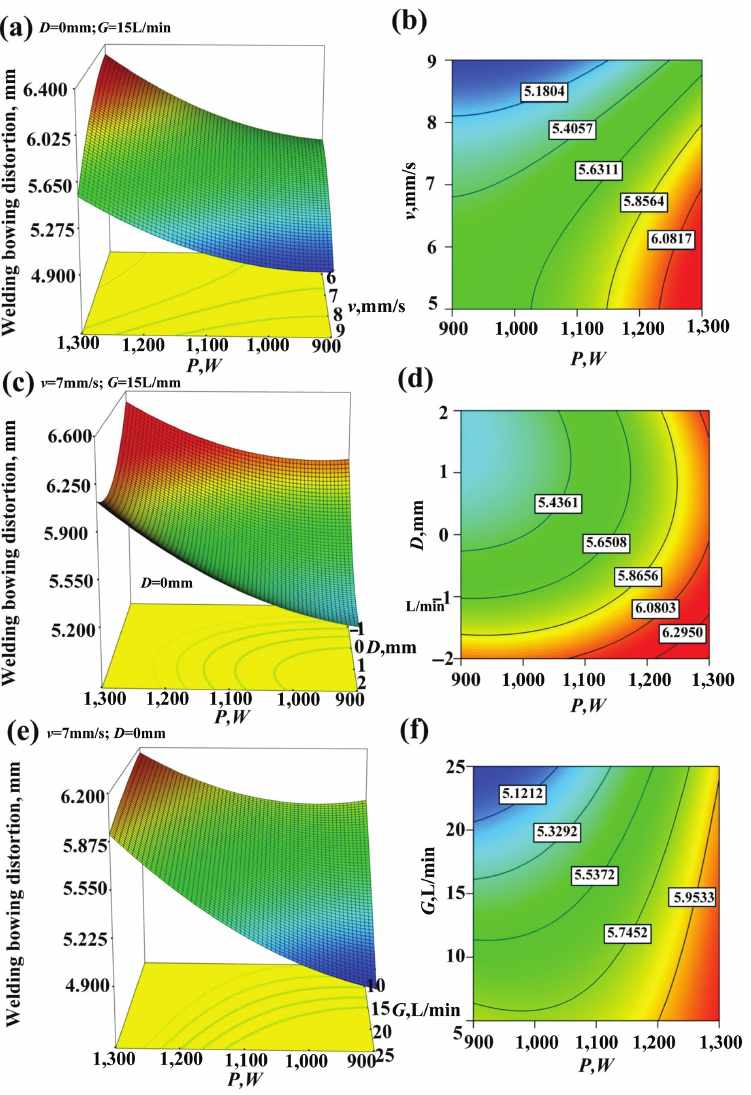
Figure 8: 3D response surface graphs and con- tour plots based on the quadratic model: (a), (c), (e) response surface graphs demonstrating the interaction effects of laser power with the other three welding parameters; (b), (d), (f) con- tour plots of (a), (c), (e),